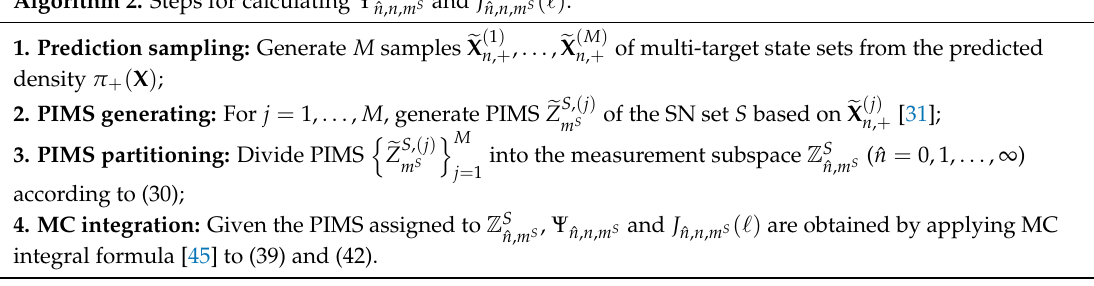
Algorithm 2. Steps for calculating Ψ ˆ n